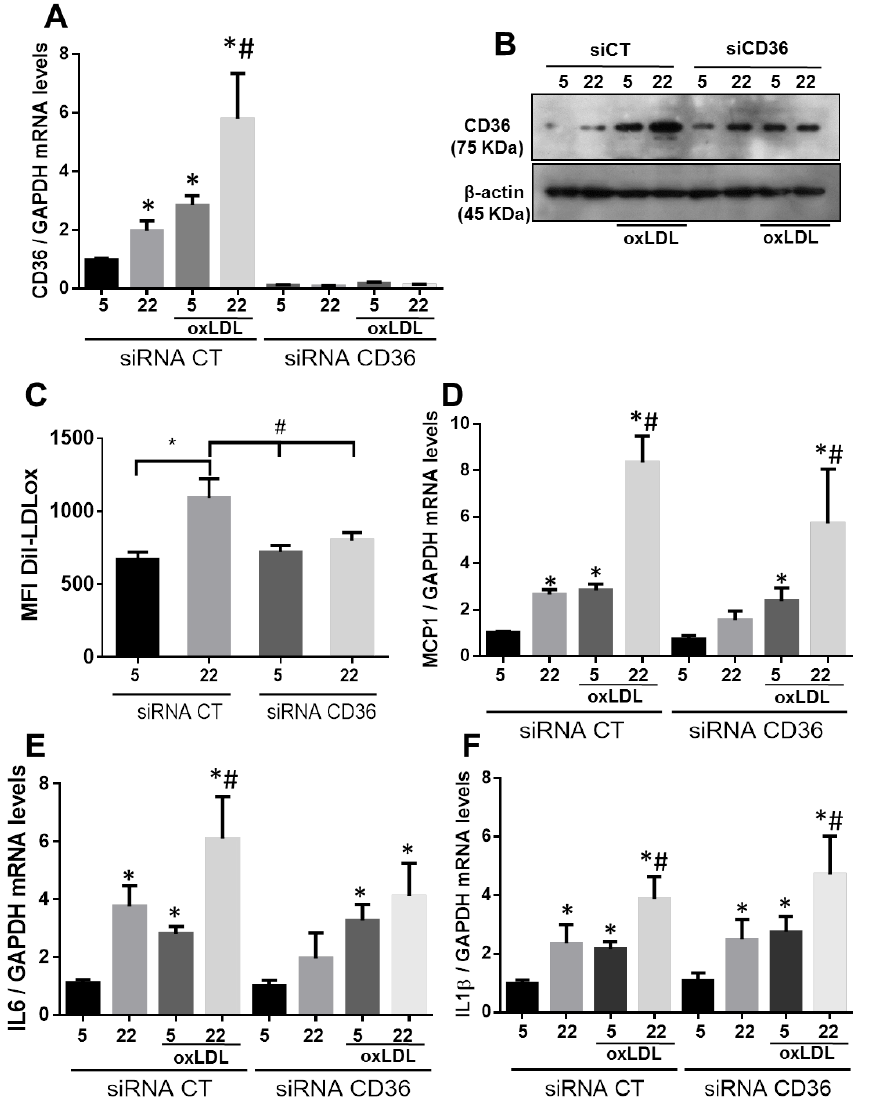
Figure 4. Silencing of CD36 gene expression blunts oxLDL uptake by VSMC but does not affect inflammatory markers expression. ( A , B ) Histogram showing the quantification of CD36 mRNA